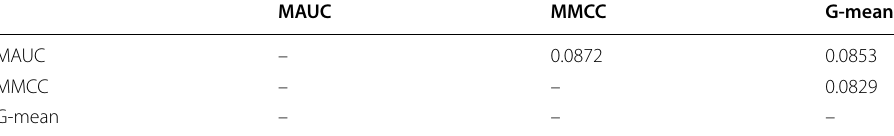
Table 18 Experimental results for verifying degree of indifferency (E) o evaluation